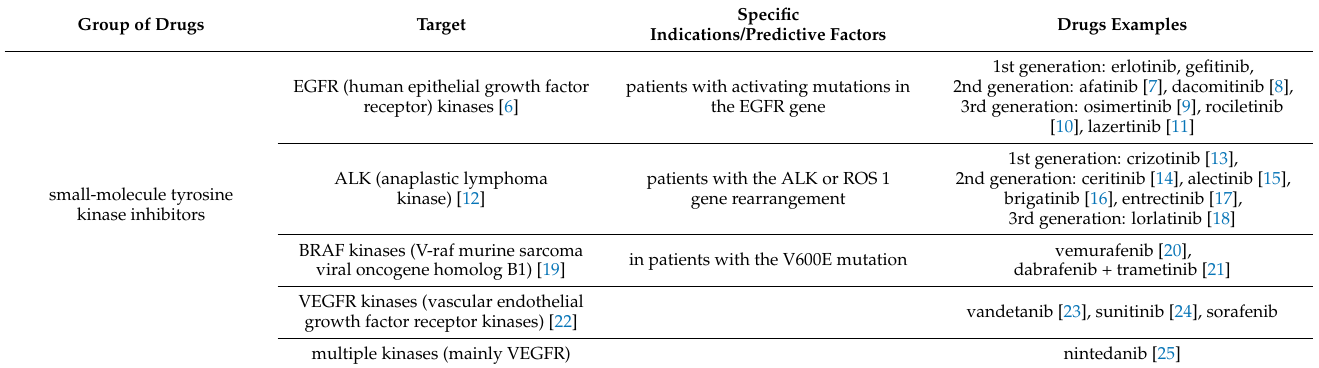
Table 1. Molecular target therapy used in